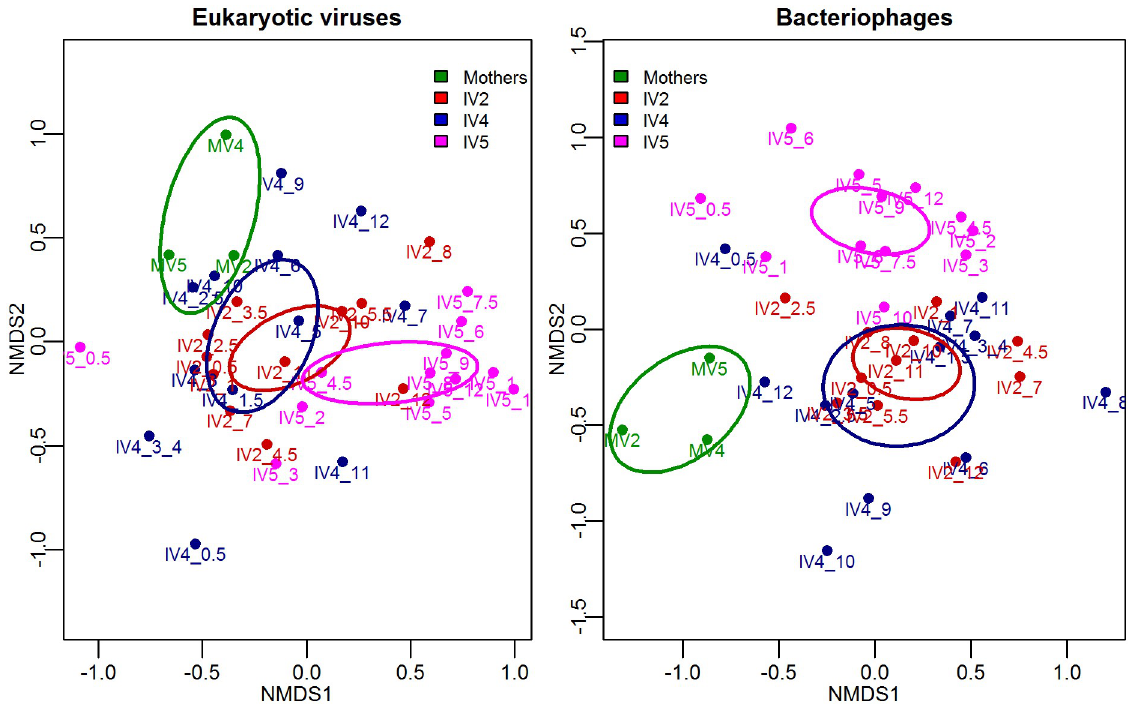
Fig 6. Multidimensional Scaling (MDS) analysis of eukaryotic viruses and bacteriophages at the species level. Bray-Curtis dissimilarity distances from normalized counts were used. Each point corresponds to a sample, and ellipses represent the standard errors of the centroids of the types of samples (mothers, infant 2, infant 4 and infant 5). Ellipses were calculated using the Ordiellipse function of the R package ‘vegan’ [37], at 95% confidence.